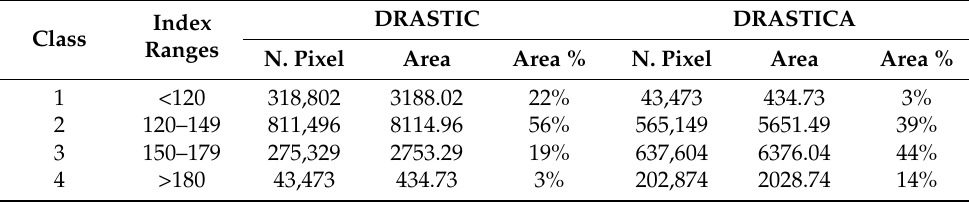
Figure 8. DRASTICA index map of Chitral district. Table 5. Comparison between the DRASTIC and DRASTICA risk maps [32].